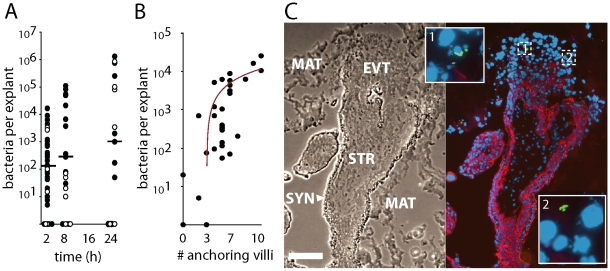

L. monocytogenes grows variably in placental explants.(A) Intracellular survival of L. monocytogenes in 86 explants from 18 placentas infected with ∼2×106 10403S (filled circles) or EGDe (open circles) wild type strains for 30 min. Gentamicin was added at 60min to kill extracellular bacteria and maintained in media thereafter. Infection is highly variable and growth is slower than in most cell lines. Bars = median values. (B) Number of internalized bacteria at 2 h post inoculation (p.i.) correlates with the number of anchoring villi in the explant (n = 30 explants, r2 = 0.49). (C) Histological section of explant frozen and sliced at 8 h p.i., then stained for L. monocytogenes (green), DNA (blue), and EGFR (red), which stains trophoblast membranes. Bacteria are found in extravillous cytotrophoblasts (EVT) but not syncytiotrophoblast (SYN). Matrigel (MAT) and stroma (STR) are also indicated. Bar = 100 µm.